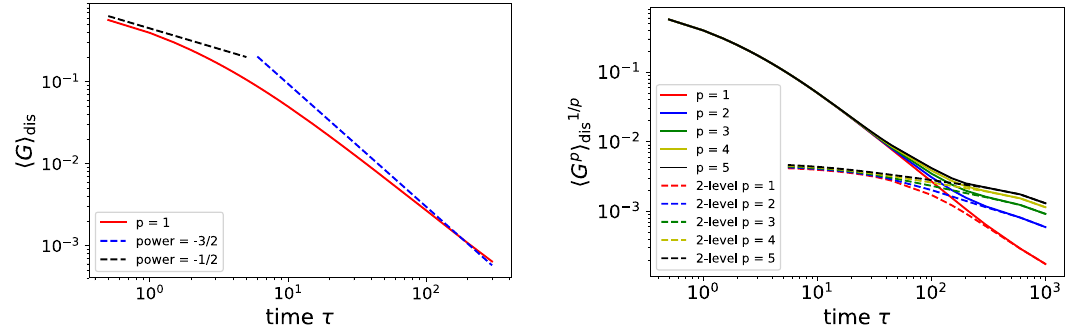
Figure 1 . (a) Numerical results for at N = 32 averaged over 30 realizations (Log-Log G ( τ, 0) (cid:31) (cid:30) dis plot). At short time, it decays with power 1 / 2, while at long time it decays with power − 1 /p in time domain (Log-Log plot). The dashed lines are Green’s Numerical results for G ( τ, 0) p dis (cid:30) (cid:31) functions obtained by taking into account the contribution from the lowest two eigenstates only. Time is measured in units of 1 /J